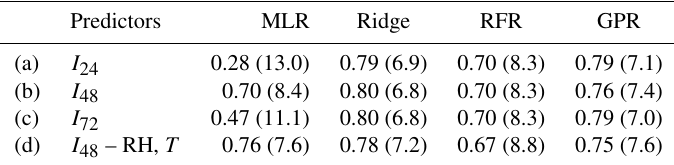
Table 3. Sensor skill depending on the selection of predictors for PM 10 sensor 26 at location CarPark. Shown are the R 2 scores and RMSEs (in brackets) evaluated over 914h of test data, after training and cross-validating the algorithms on 400h of data. RMSEs are given in µgm − 3 . In (d), relative humidity (RH) and temperature ( T ) are removed from the calibration variables to test their importance for the measurement